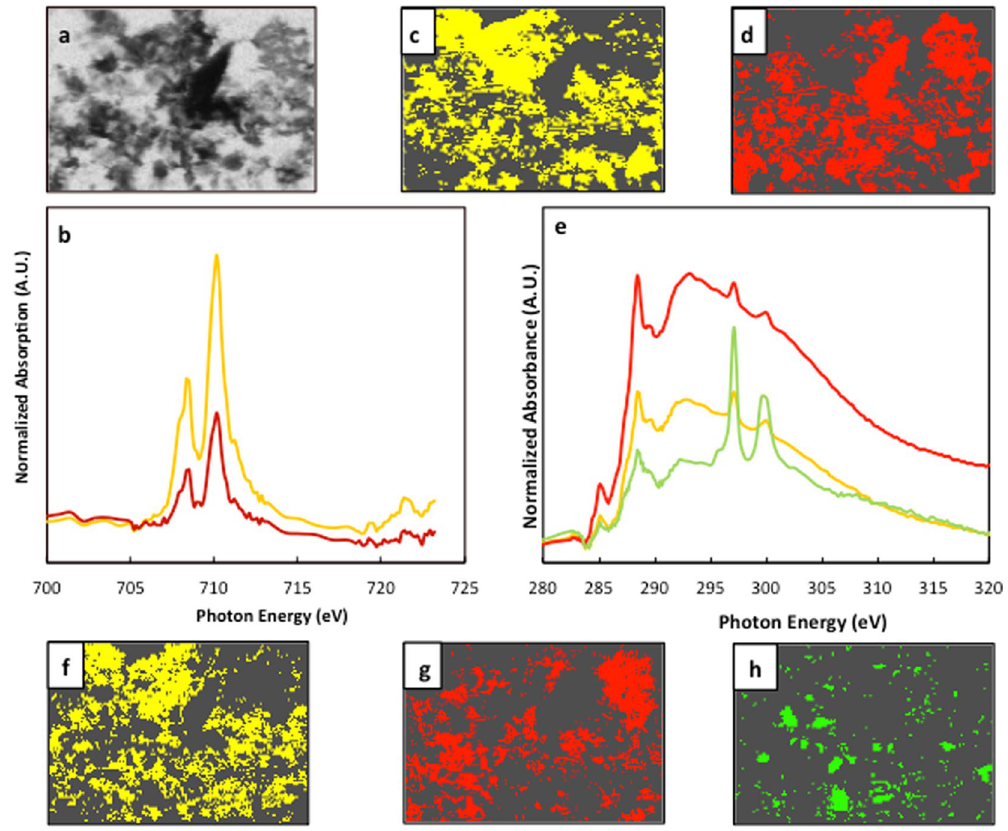
Figure 5. Chemical composition of co-localized iron (panels a and b–d) and organic matter (panels a and e–h). ( a ) Representative 12 × 8 μ m X-ray microscopy image from the Mexican Margin sediment (Station 306); ( b ) Iron L 3 edge XAS spectra for the Fe cluster maps in panels ( c – e ) Carbon K-edge XAS spectra for the ( c ) cluster maps in panels ( f – h ). Note that colored traces in panels ( b and e ) correspond to the different coloured carbon clusters in panels ( c,d and f–h ), respectively. Each cluster was identified using the PCA and clustering analysis described in the methods